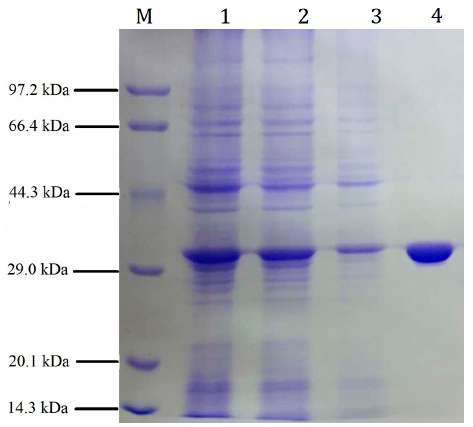
Figure 3. Sodium dodecyl sulphate-polyacrylamide gel electrophoresis (SDS-PAGE) analysis of total expressed cell proteins from E. coli (harboring pET28a-(His)6-pfGDPD-(His)6) vector and the eluted fractions from nickel-chelate chromatography. Lanes M : Molecular marker; Lanes 1 : Total cell lysate; Lanes 2 : Supernatant of total cell lysate that centrifugated with 11,000× g for 10 min; Lanes 3 : Precipitation of total cell lysate that centrifugated with 11,000× g for 10 min; Lanes 4 : Nickel-chelate chromatography and eluted with washing buffer that contained 200 mM imidazole.